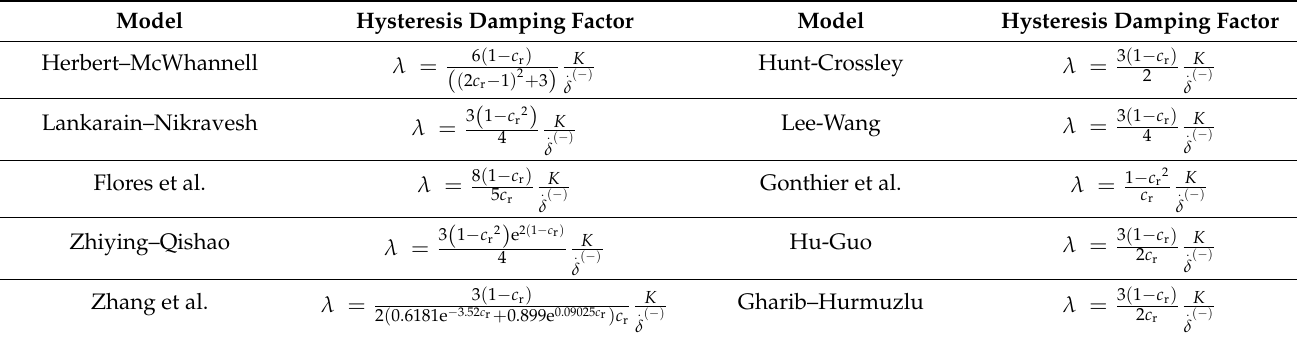
Table 1. Classical expressions of hysteresis damping